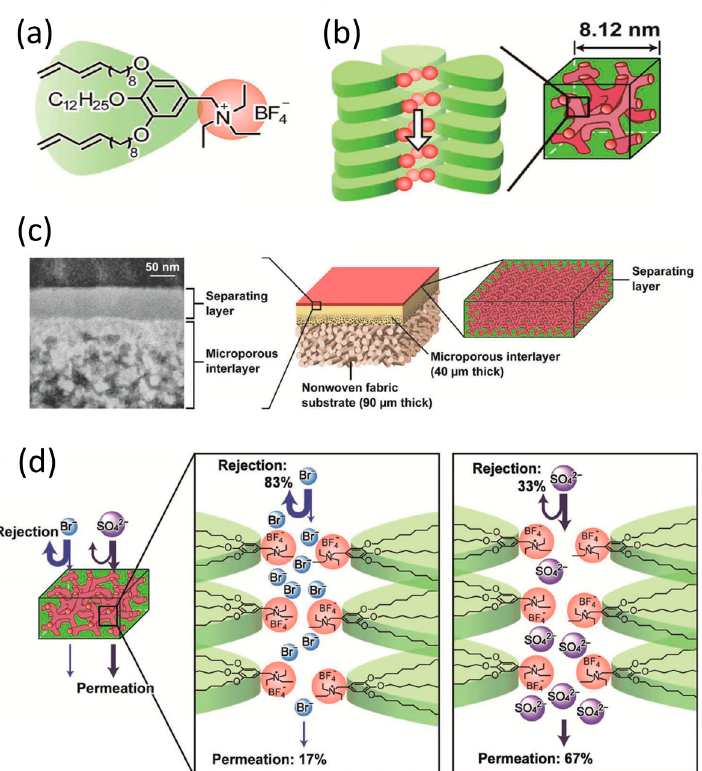
Figure 13. A thin separating layer based on a bicontinuous cubic polymer network. ( a ) Chemical structure of the wedge-shaped liquid crystalline monomer; ( b ) Self-assembled bicontinuous cubic LC phase forming ionic nanochannels; ( c ) Polymer membrane containing the polymerized liquid crystal network as a separating layer; ( d ) Schematic representation of selective rejection of anions through the membrane. Adapted from [89], licensed by John Wiley and Sons, Inc. (Hoboken, NJ, USA).